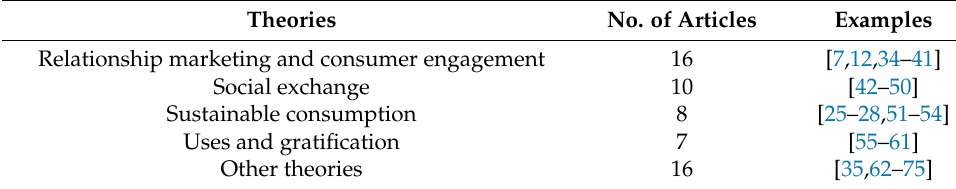
Table 1. Theories used in studies on consumer engagement in social media in the context of sustain- able consumption.